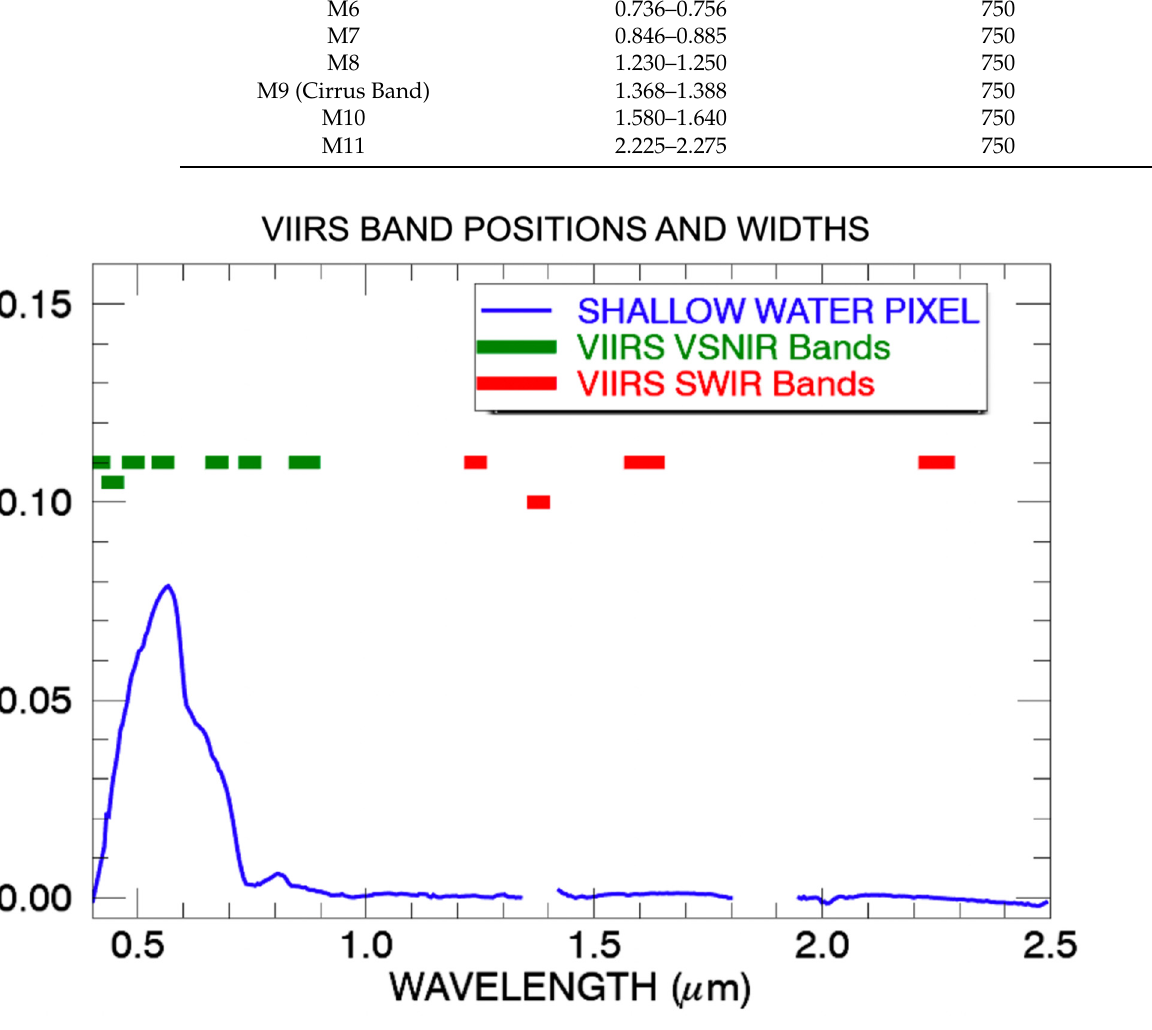
Figure 2. Bandpasses of VIIRS M bands in the 0.4–2.5 µ m solar spectral range. A measured reflectance spectrum over a shallow water area having reflection from the bottom is also shown.